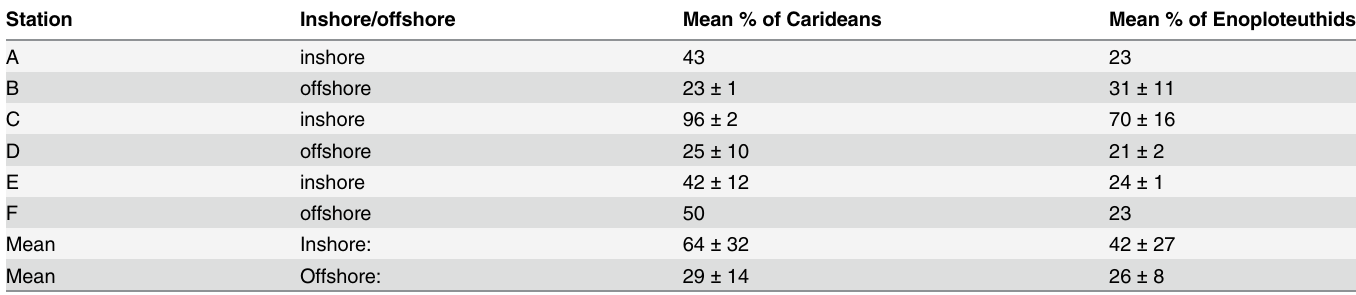
Table 6. Results of trawl samples analysis. With station name (see Fig 4), inshore vs. off-shore location, proportion of Oplophorus gracilorostris in cari- dean shrimps, and proportion of Abralia trigonura in enoploteuthid squids.